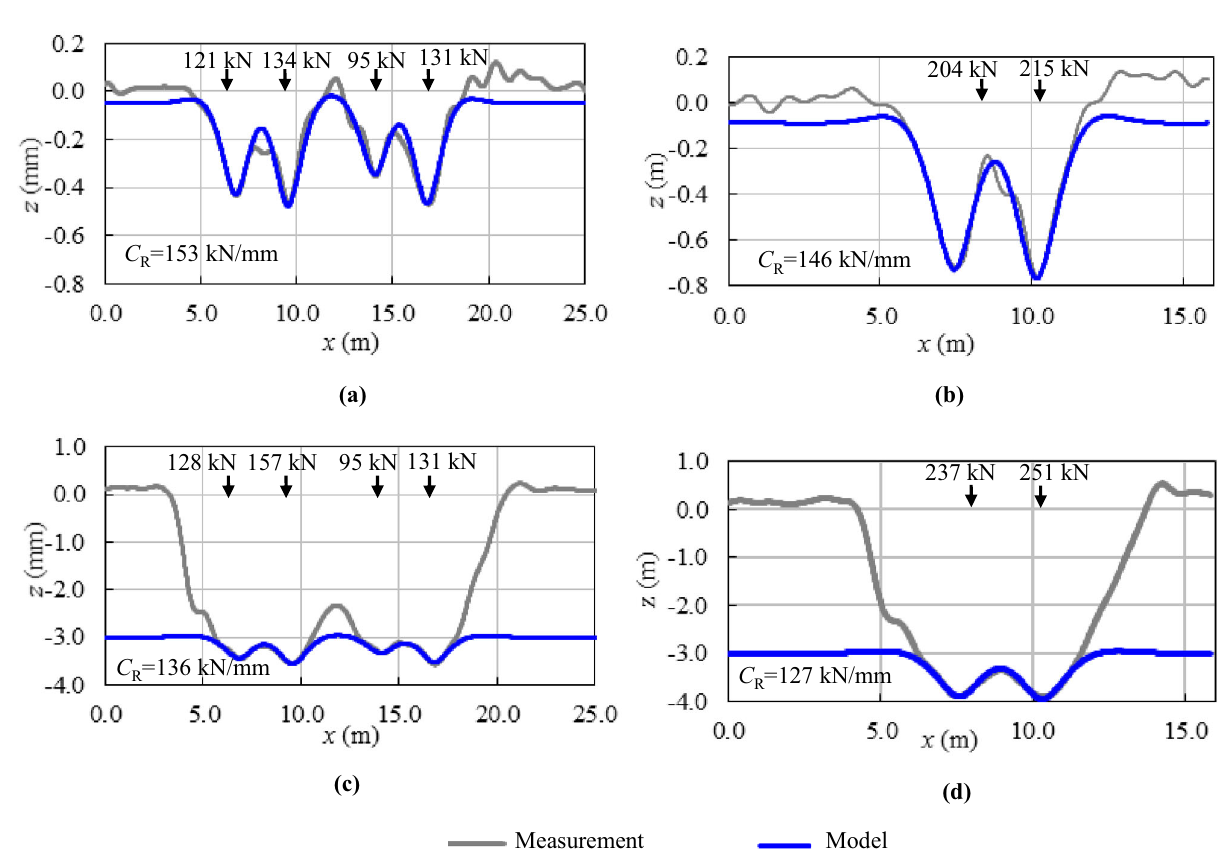
Fig. 11 Identification of axle loadings and the local track stiffness in the voided zone ( a , b ) and the reference zone without voids ( c , d ), for the passenger car ( a , c ) and the locomotive ( b , d